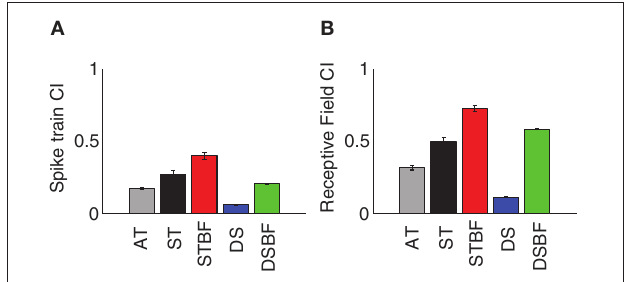
FIGURE 7 | Receptive field and spike train correlation statistics for neighboring ICC neurons. The average absolute spike train CI (A) and receptive field CI (B) both increases with proximity (AT, gray vs. ST, black ) and BF match (ST, black vs. STBF , red ). All examples are shown for three experimental groups (AT, gray ; ST, black ; STBF, red ) and two control groups (DS, blue ; DSBF, green ). The error bars represent the bootstrapped SE.